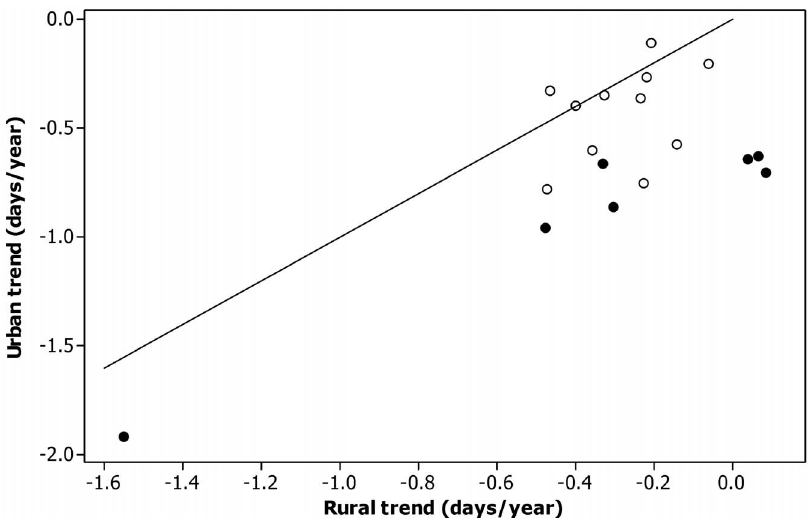
Figure 2. The relationship between rural and urban trends in first arrival dates in Western Poland 1983 – 2010. Points below the line represent species whose migration trend was stronger (more negative) in urban areas than rural areas and vice versa . Solid symbols represent short